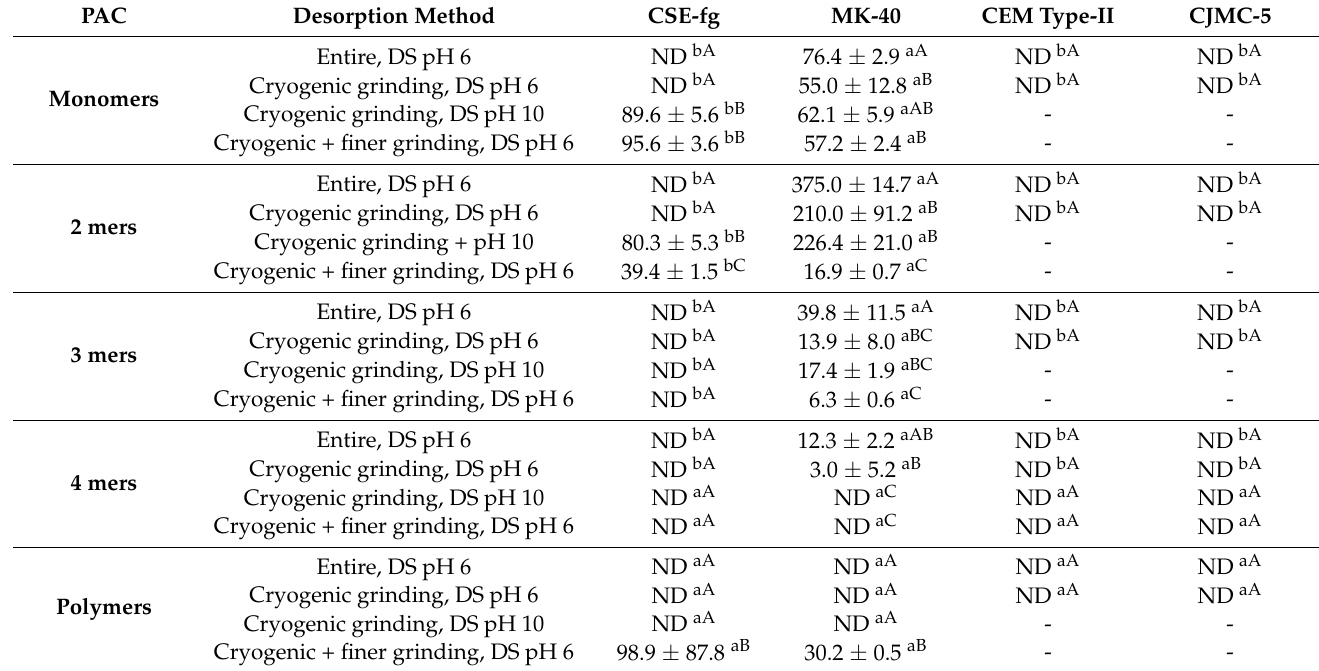
Table 7. Proanthocyanidin content of desorption solutions (DS) ( µ g PACs/cm 3 membrane).